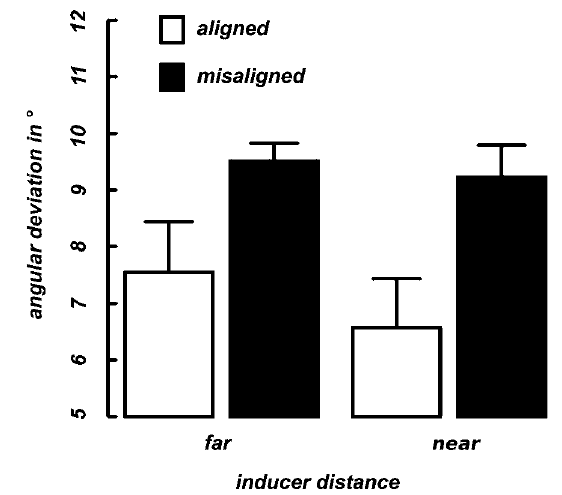
Figure 3. Mean thresholds. Shown are 75% performance thresholds in units of angular deviation from 90 ° averaged across nine participants as a function of inducer distance (x-axis) and alignment (differently colored bars). Error bars indicate the standard error of the mean for each condition.